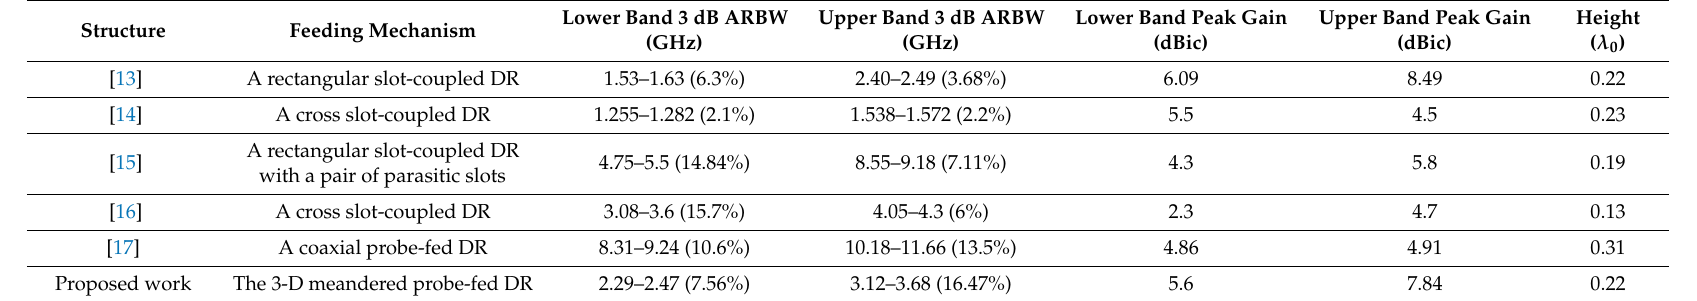
Table 3. Comparison of the proposed antenna with those used in earlier published